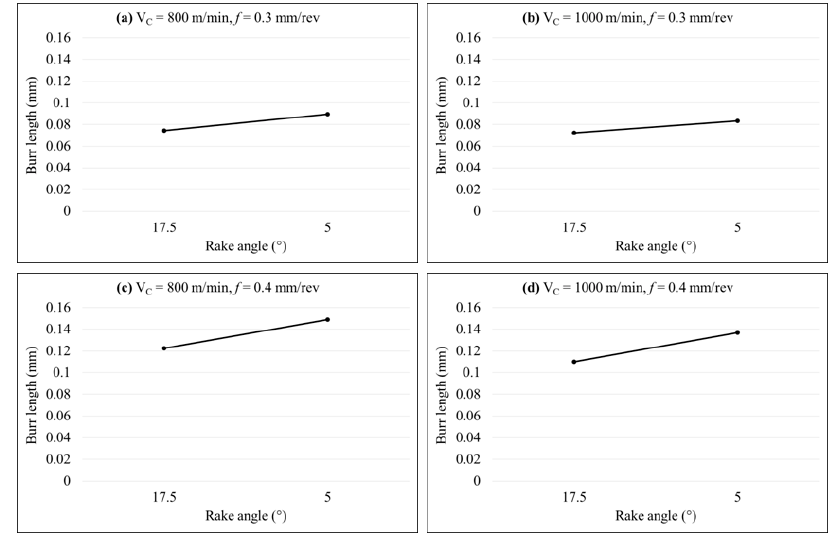
Figure 7. Effect of rake angle on end burr lengths along x-axis at Z = 0 (mid-section along depth of cut) ( a ) V C = 800 m/min, f = 0.3 mm/rev ( b ) V C = 1000 m/min, f = 0.3 mm/rev ( c ) V C = 800 m/min, f = 0.4 mm/rev ( d ) V C = 1000 m/min, f = 0.4 mm/rev.